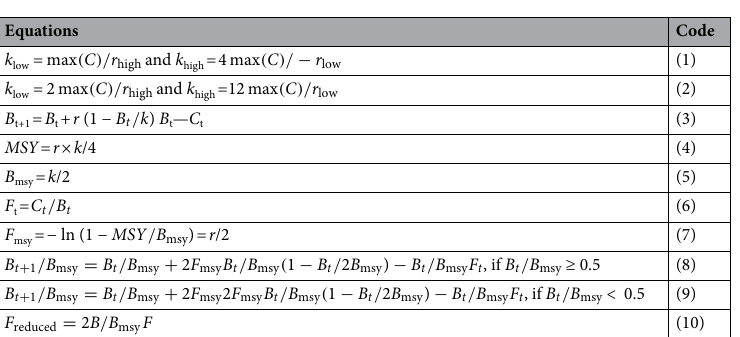
Table 3. Equations for parameters determination in CMSY. k the carrying capacity, k low and k high the lower and upper bounds for k respectively, r the maximum intrinsic rate, r low and r high the bounds for priori r values, B t+1 the biomass in year t + 1, C t the catch in year t, max (C ) the recorded maximum catch, MSY the maximum sustainable yield, B t the biomass in year t, B msy the biomass capable of producing best maximum sustainable yields, F t the fishing mortality in year t, F msy the fishing mortality capable of producing maximum sustainable yields.